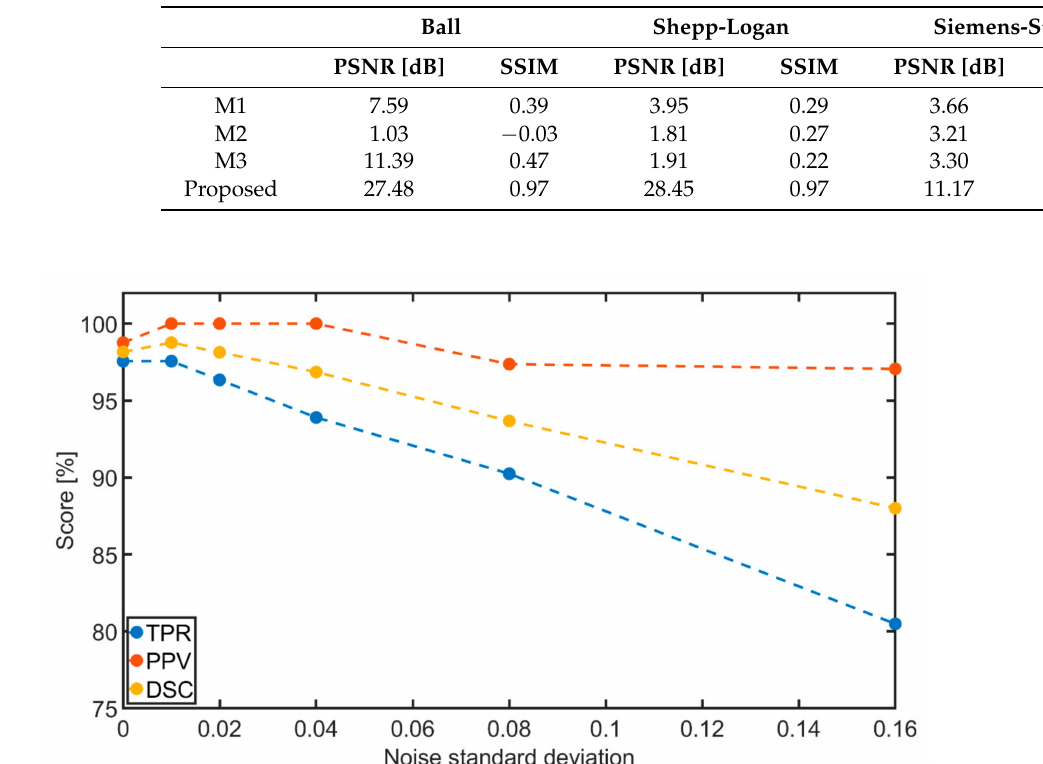
Figure 7. Dependence of the accuracy of the proposed HRA detection scheme on the noise level—evaluated for Shepp-Logan phantom.